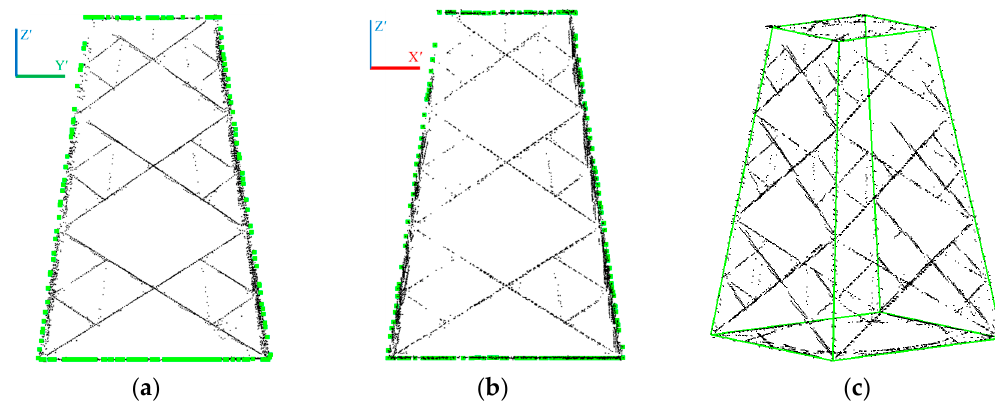
Figure 15. The frame of a quadrangular frustum pyramid: ( a,b ) 2D contour points extracted by 2D alpha shape algorithm; ( c ) the frame model of a quadrangular frustum pyramid.